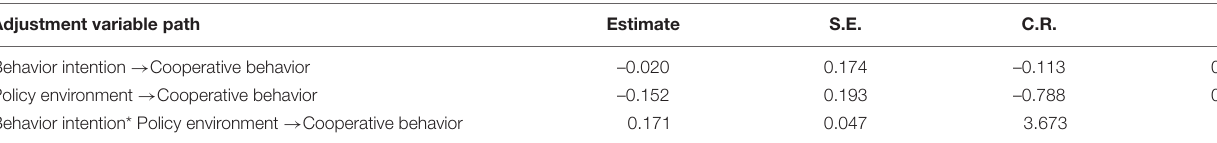
TABLE 5 | Adjustment variable